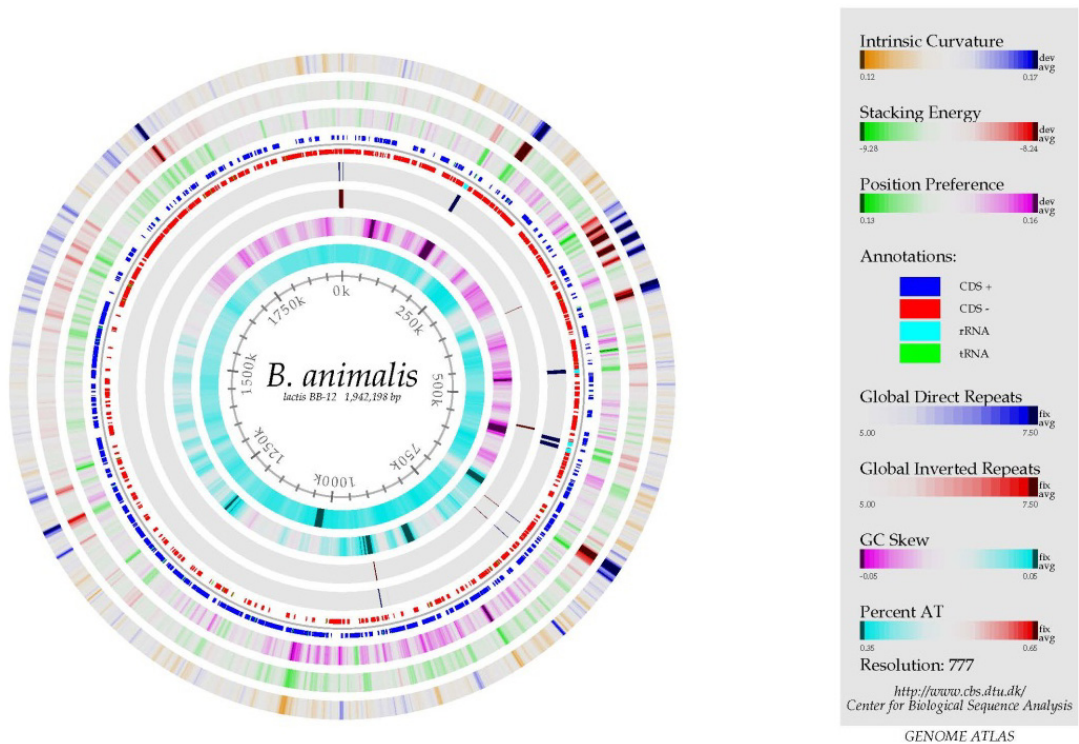
Figure 1. The BB-12 ® genome atlas. The physical mapping of the BB-12 ® chromosome revealed that the genome sequence was correctly assembled. Reproduced from Garrigues et al . 2013 [6] with permissions from Elsevier, Copyright